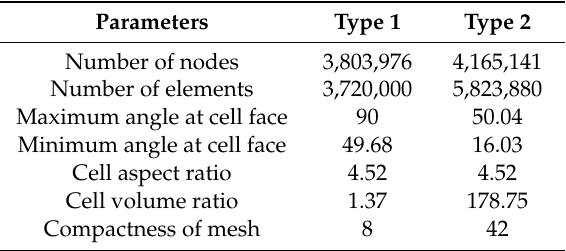
Table 1. Parameters of computational grids.